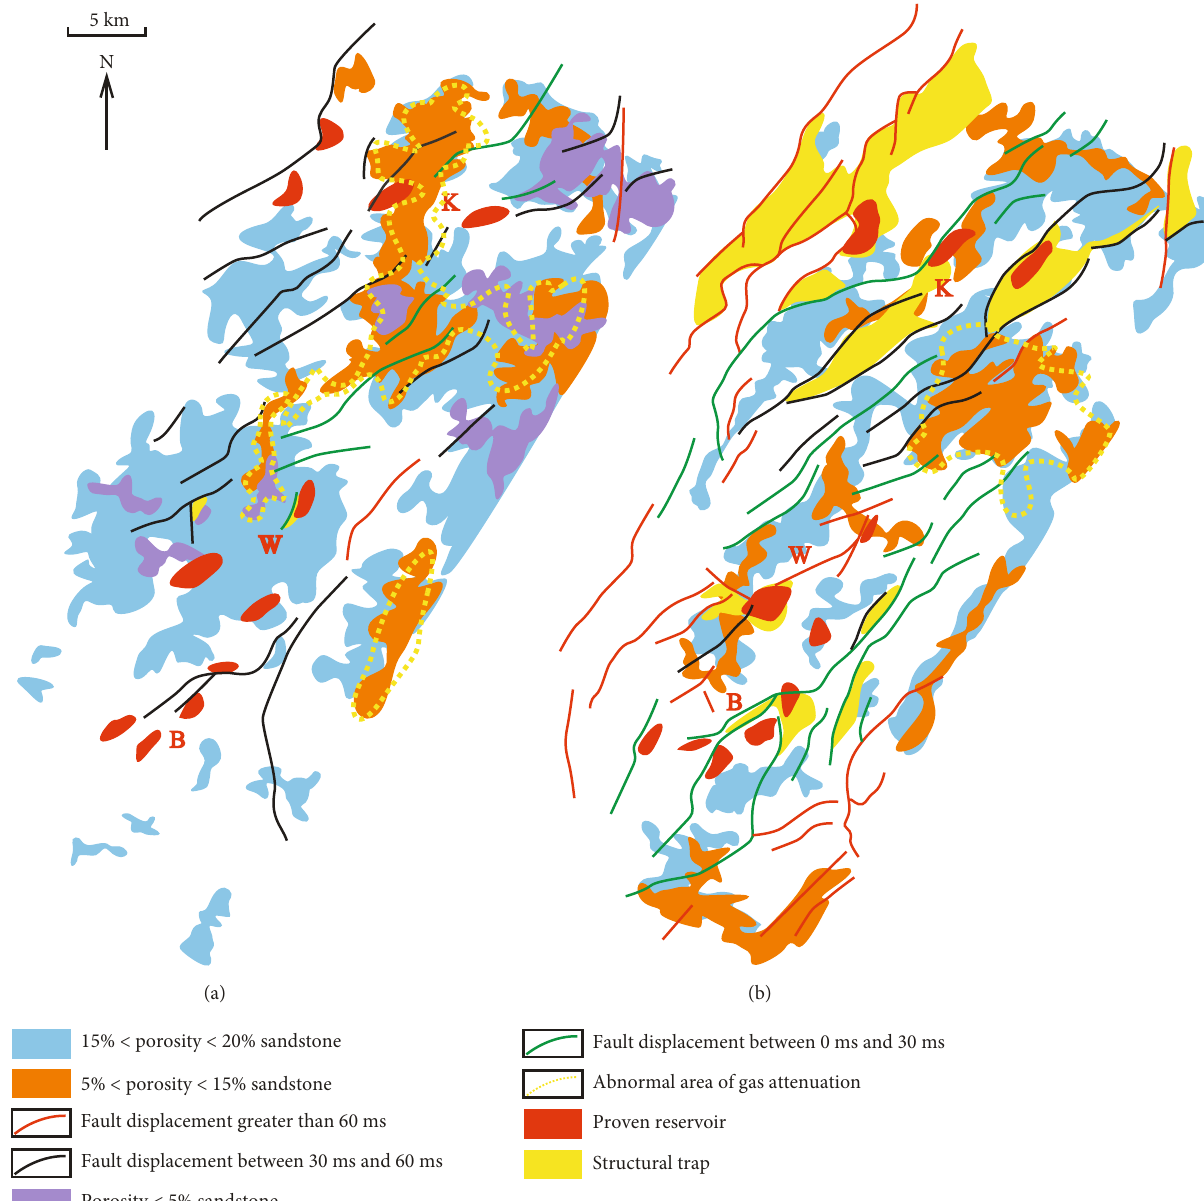
Figure 13: The relationship between the “ sweet spots ” of tight oil and gas reservoirs and the distribution of di ff erent faults: (a) tight reservoir distribution and prediction of gas-bearing traps in T31 period; (b) tight reservoir distribution and prediction of gas-bearing traps in T32